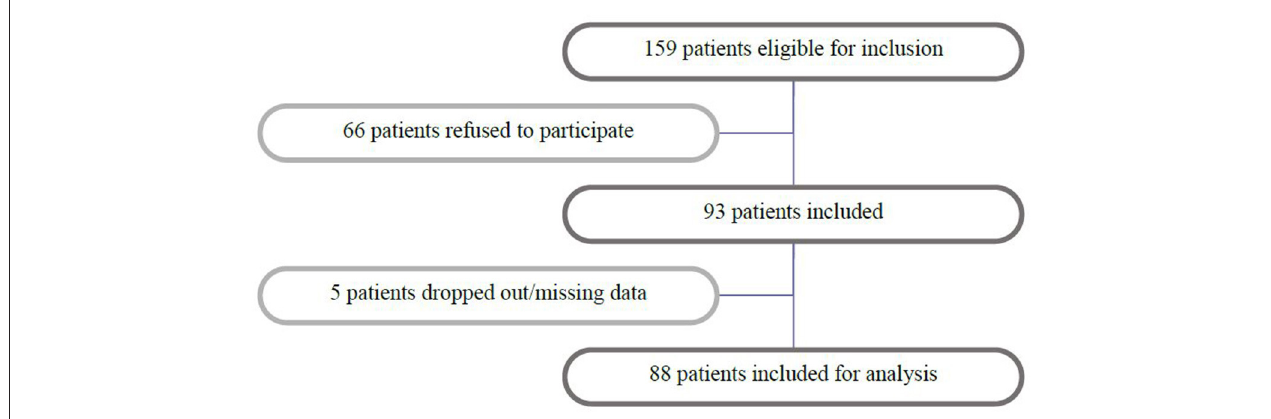
FIGURE 1 | Patient